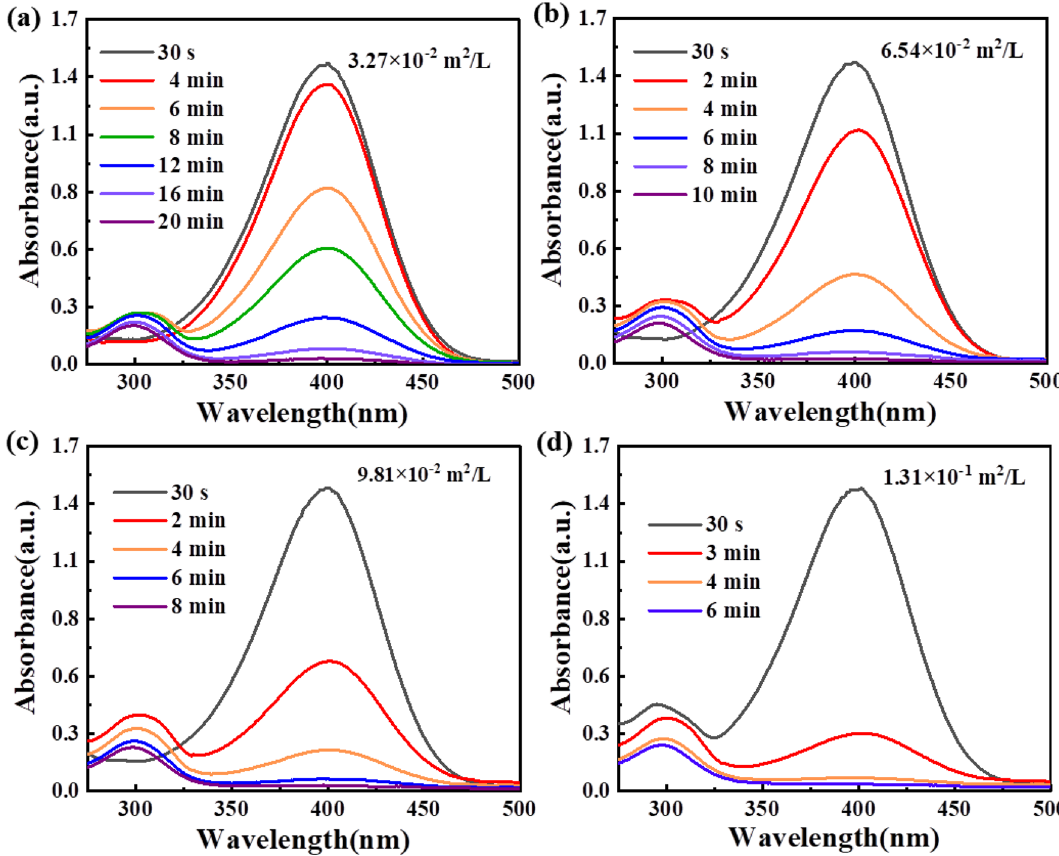
Fig. 3 The UV-vis absorption spectra of Nip reduced by sodium borohydride and catalyzed by a 25 µL, b 50 µL, c 75 µL and d 100 µL of PTBVCL-d@Au hybrid microgels (The induction period of the reaction has been s